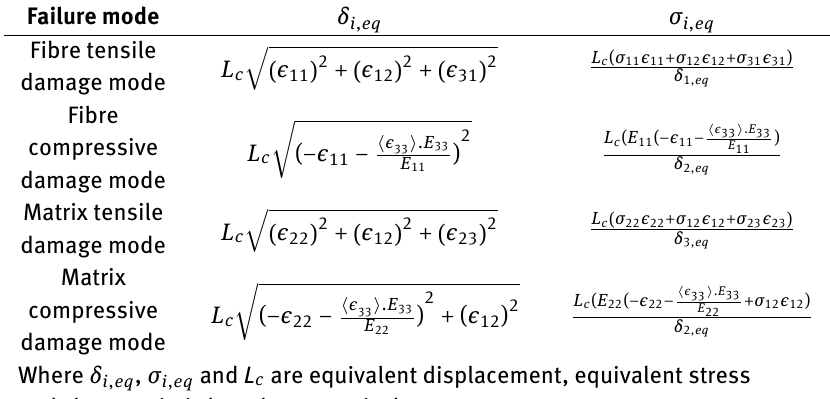
Where δ i , eq , σ i , eq and L c are equivalent displacement, equivalent stress and characteristic length, respectively. Table 5: Properties of woven Kevlar 49-Epoxy Properties data Elastic properties